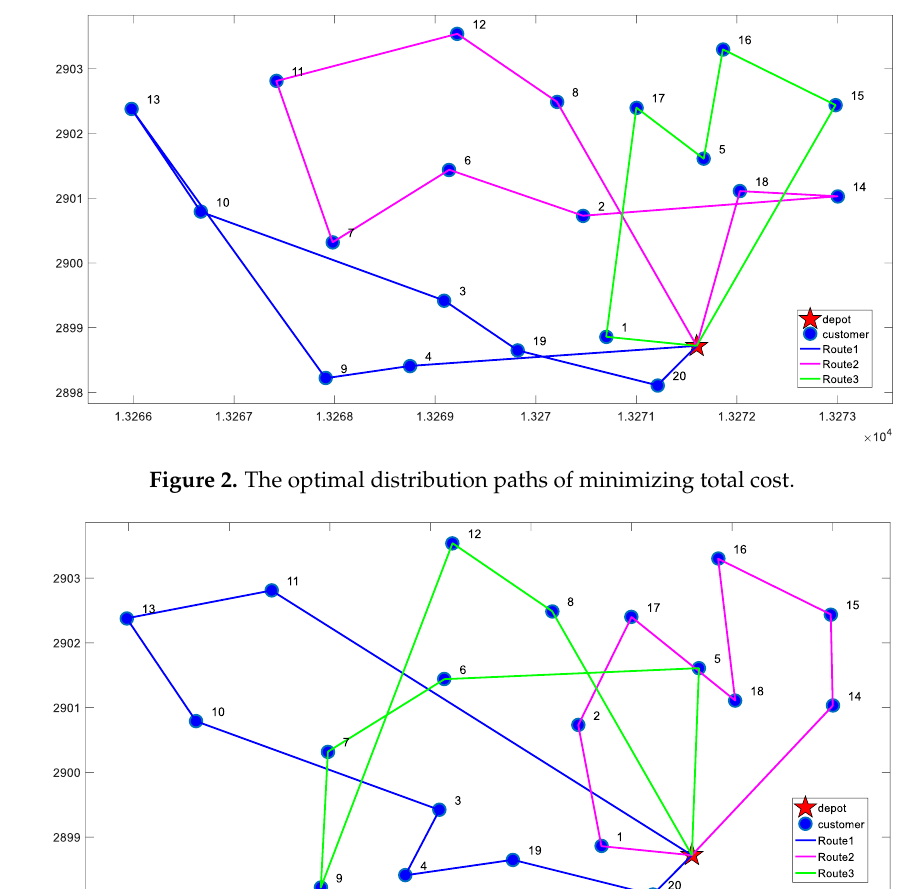
Figure 3. The optimal distribution paths of minimizing the cost of unit satisfied customer.